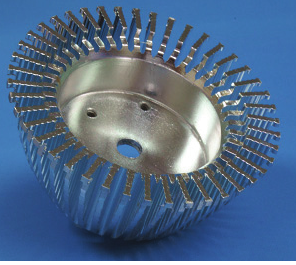
Fig. 1. Typical heat sink for a high-power MR16 LED